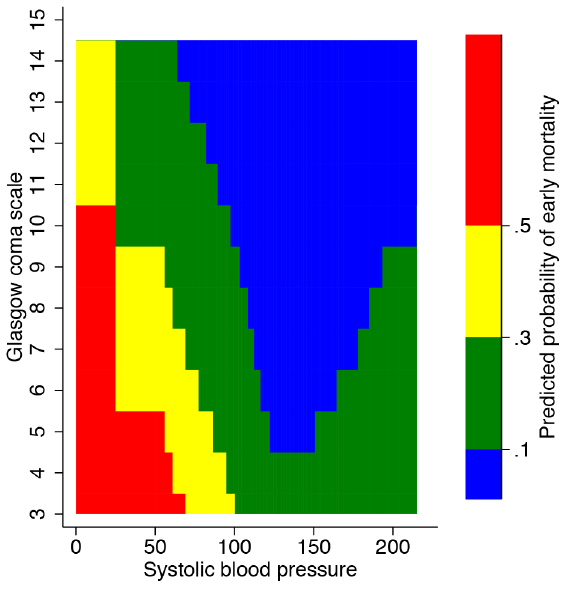
Figure 3. Heatmap based on reduced model with only systolic blood pressure and Glasgow coma